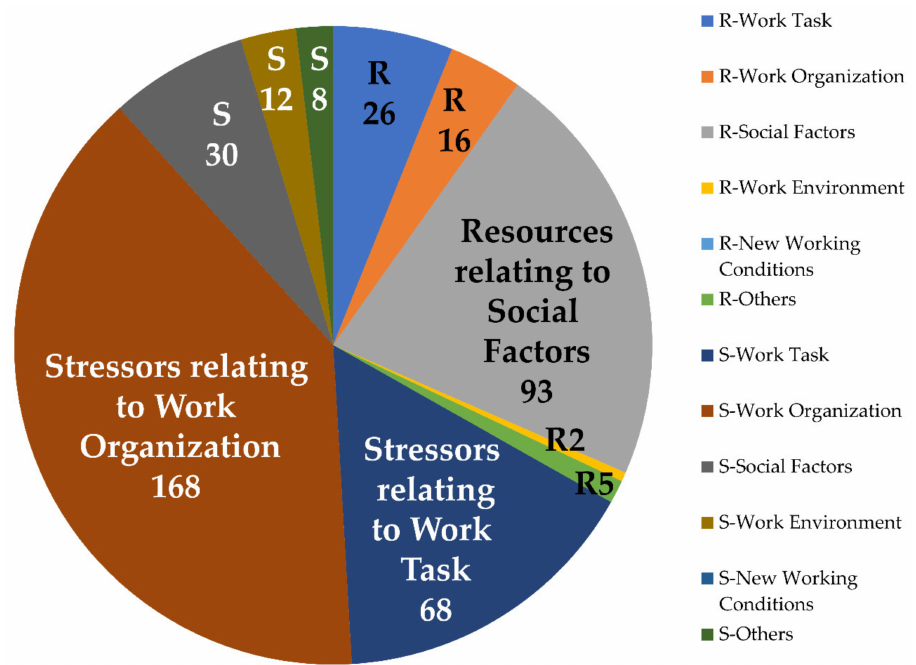
Figure 2. Graphical representation of the distributions based on the number of topics mentioned per manager and subcategory of both resources and stressors. The distribution is based on the count in Tables A2 and A3. R = Resources; S =